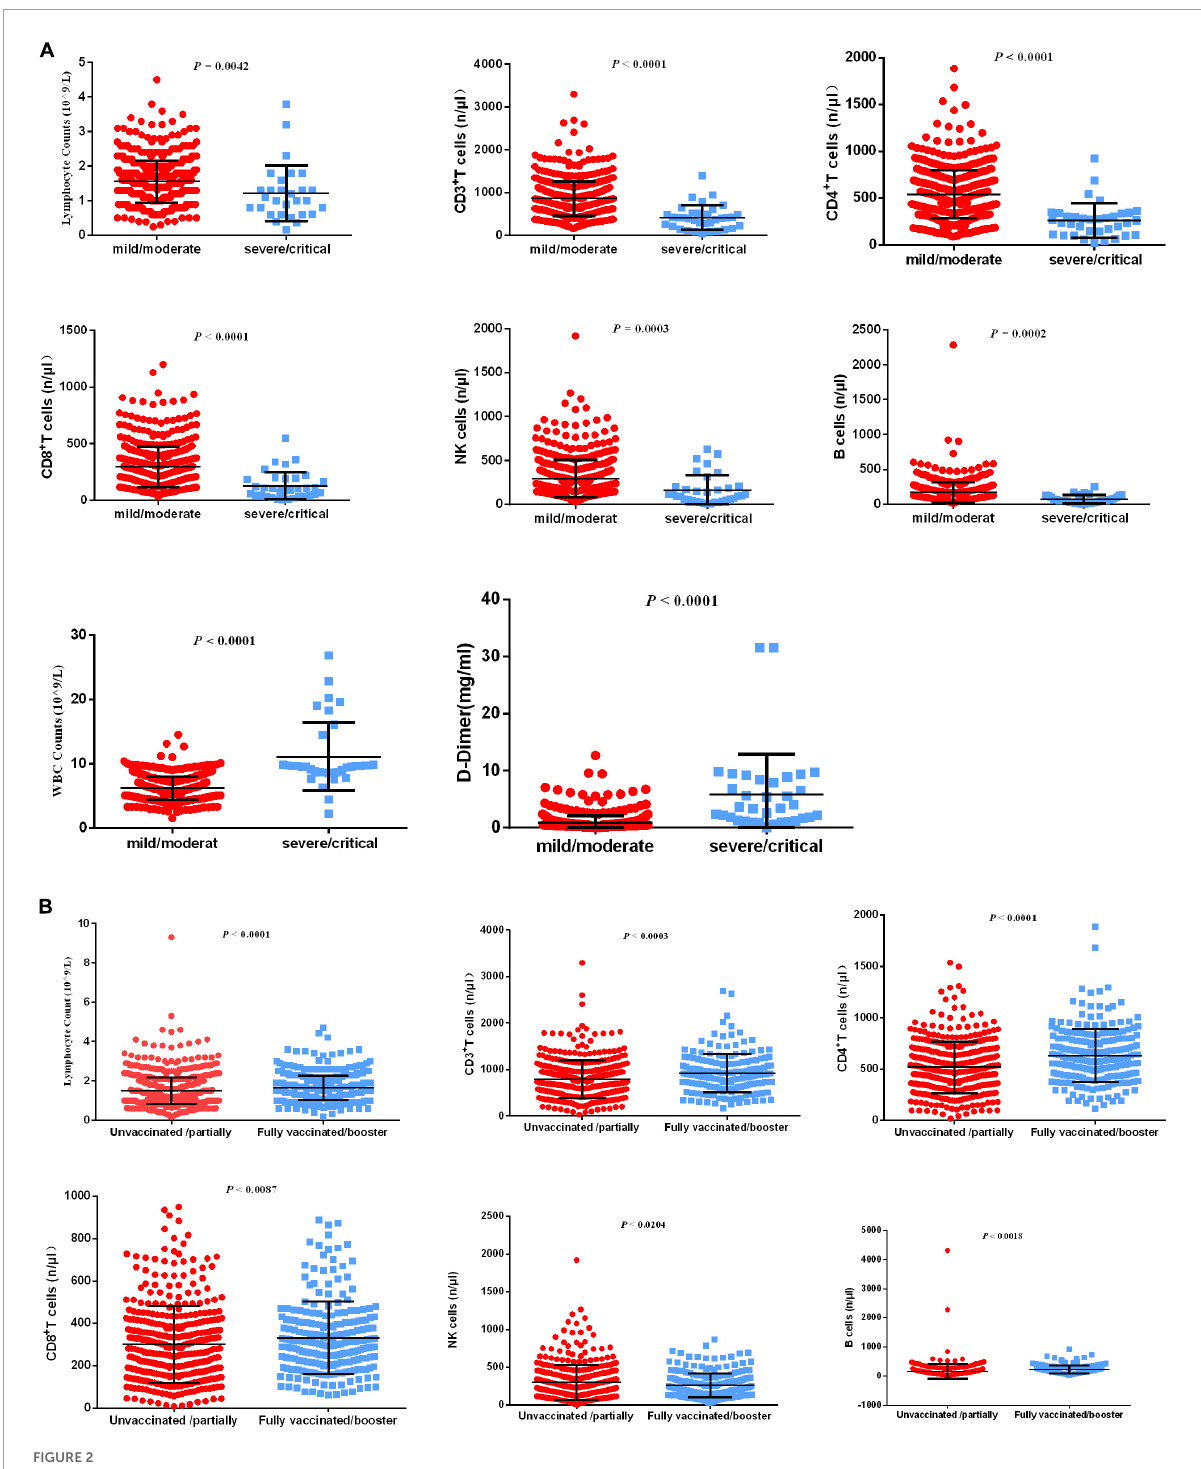
FIGURE2 Differential laboratory examinations of patients with COVID-19 infection. (A) The indicators including lymphocyte counts, CD3 + T cells, CD4 + T cells, CD8 + T cells, NK cells, B cells, WBCs, and D-dimer levels were analyzed between patients with severe/critical COVID-19 infection and patients with mild/moderate COVID-19 infection. (B) The indicators, including lymphocyte counts, CD3 + T cells, CD4 + T cells, CD8 + T cells, NK cells, and B cells, were analyzed between unvaccinated/partially vaccinated patients and fully vaccinated/booster-vaccinated